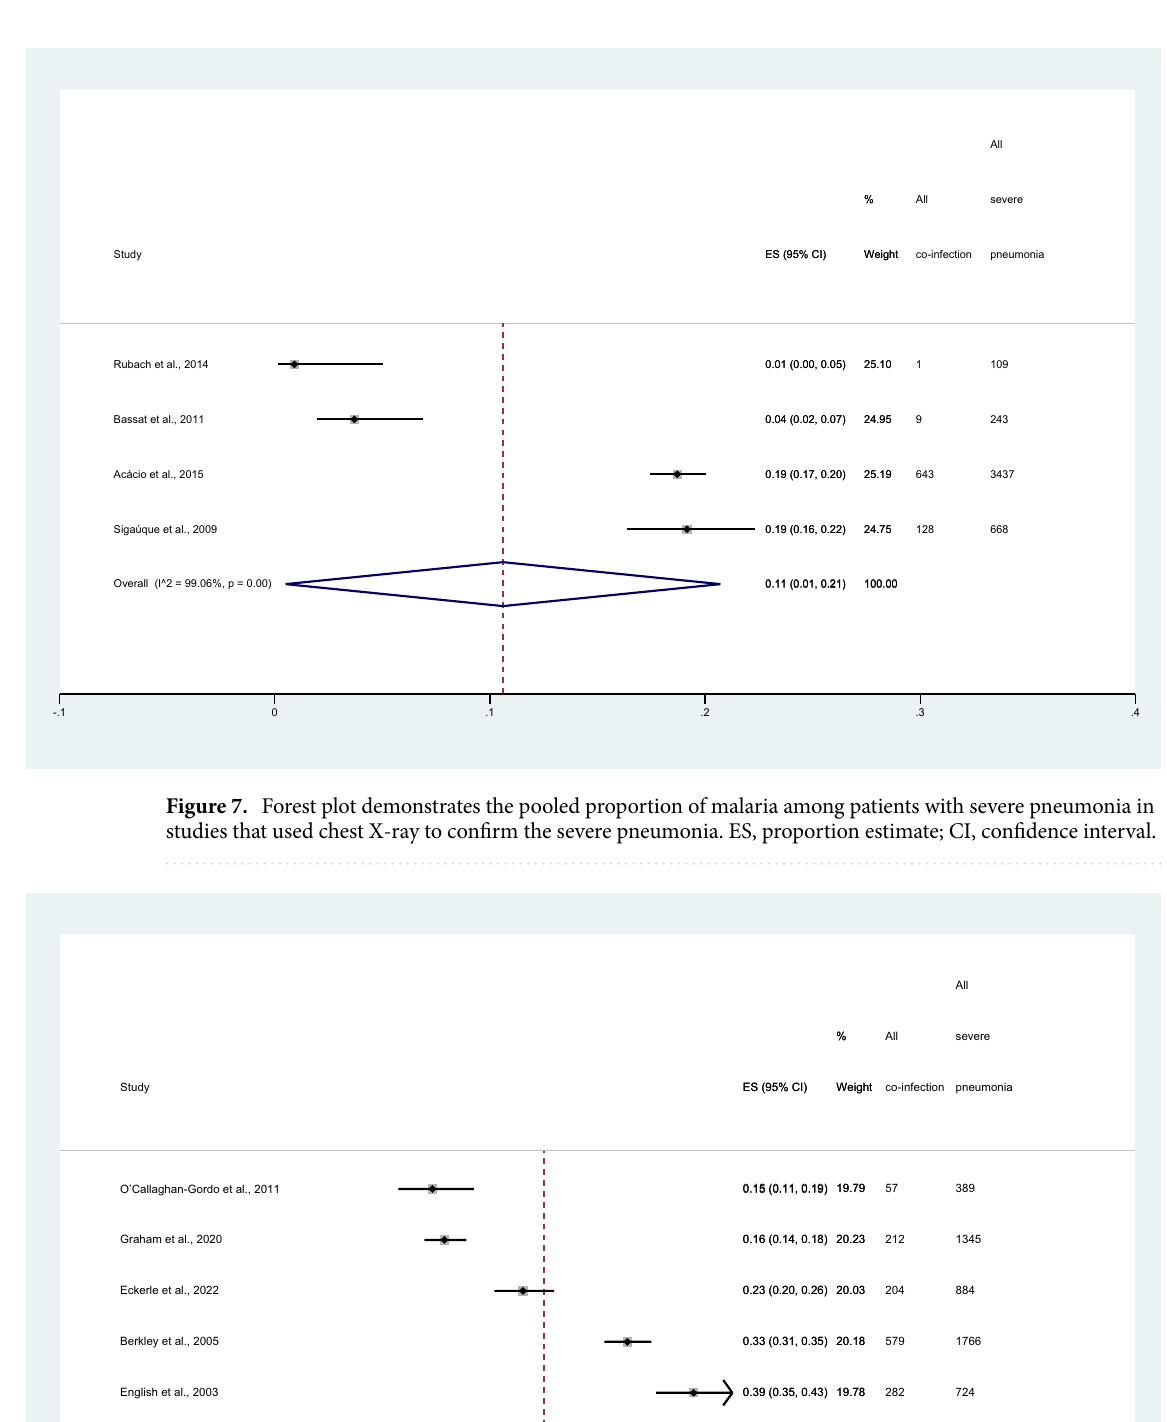
Overall (I^2 = 98.23%, p = 0.00)